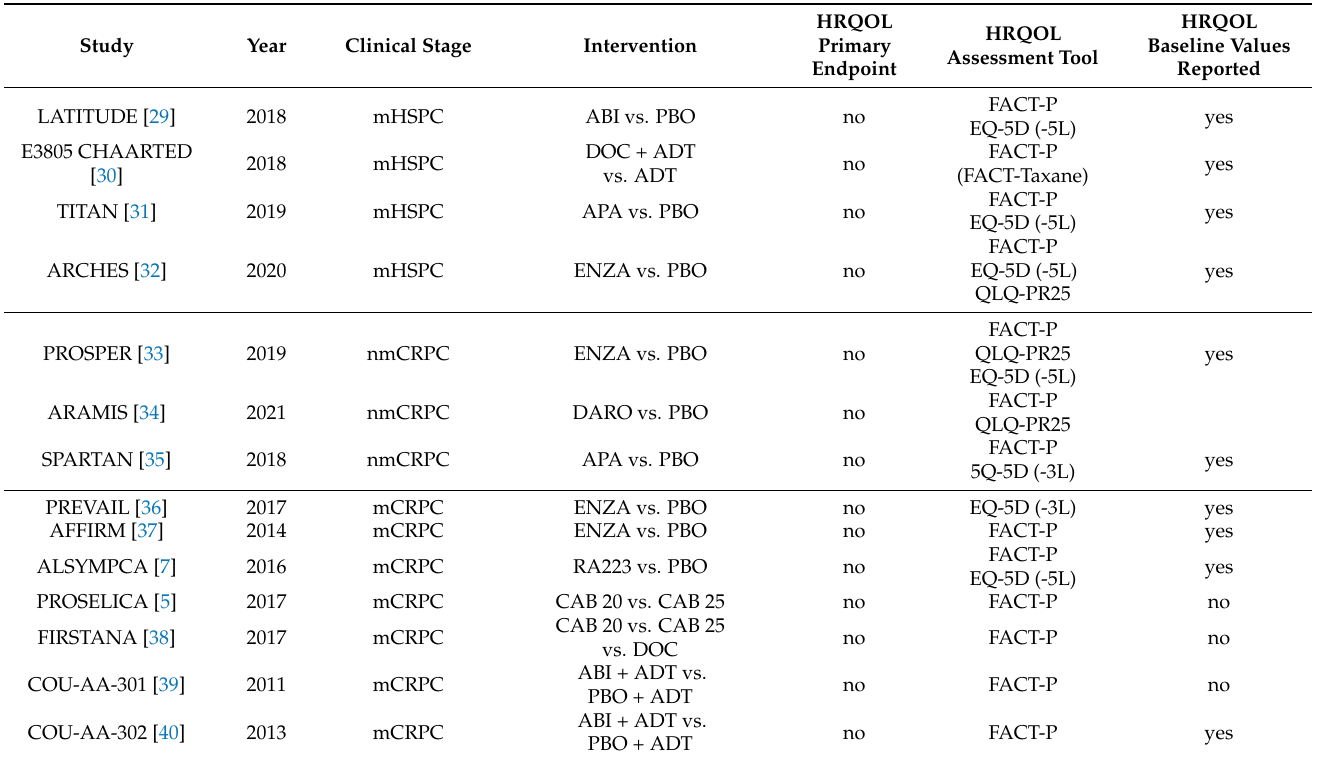
Table 1. Summary of selected contemporary randomized-controlled trials investigating health- related quality of life in patients with advanced prostate cancer (ABI = abiraterone acetate; ADT = androgen deprivation therapy; APA = apalutamide; CAB = cabazitaxel; DOC = docetaxel; ENZA = enzalutamide; HRQOL = health-related quality of life; mCRPC = metastatic castration-resistant prostate cancer; mHSPC = metastatic hormone-sensitive prostate cancer; nmCRPC = nonmetastatic castration-resistant prostate cancer; RA223 = radium-223